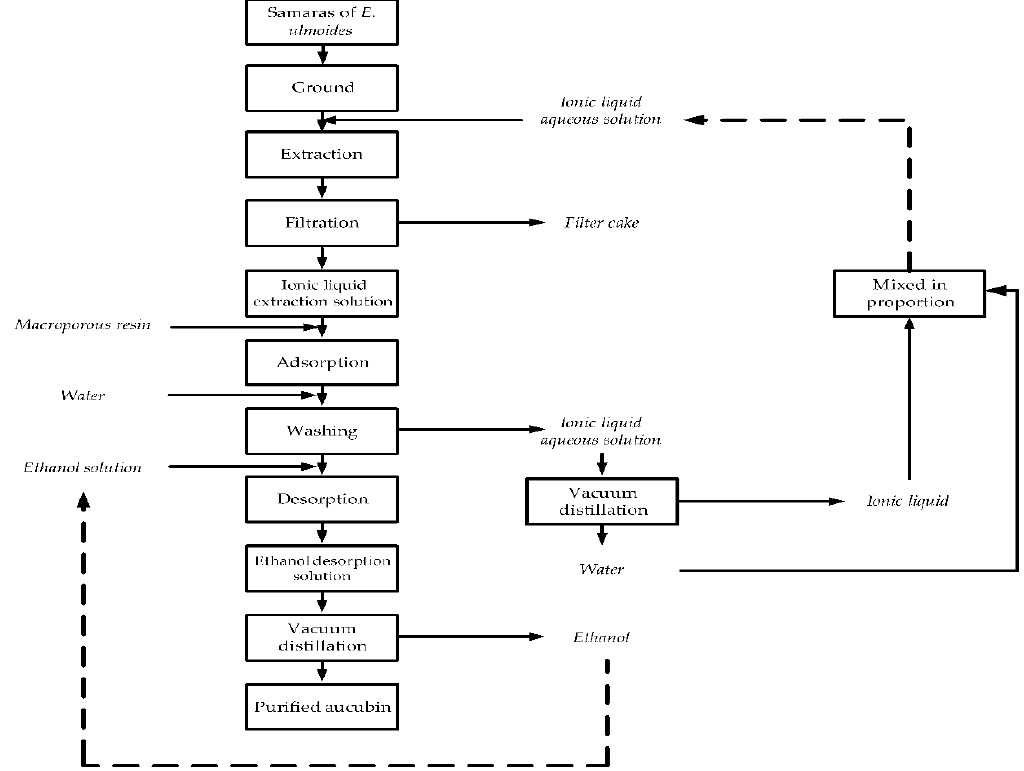
Figure 6. Process for the extraction, enrichment and purification of aucubin.